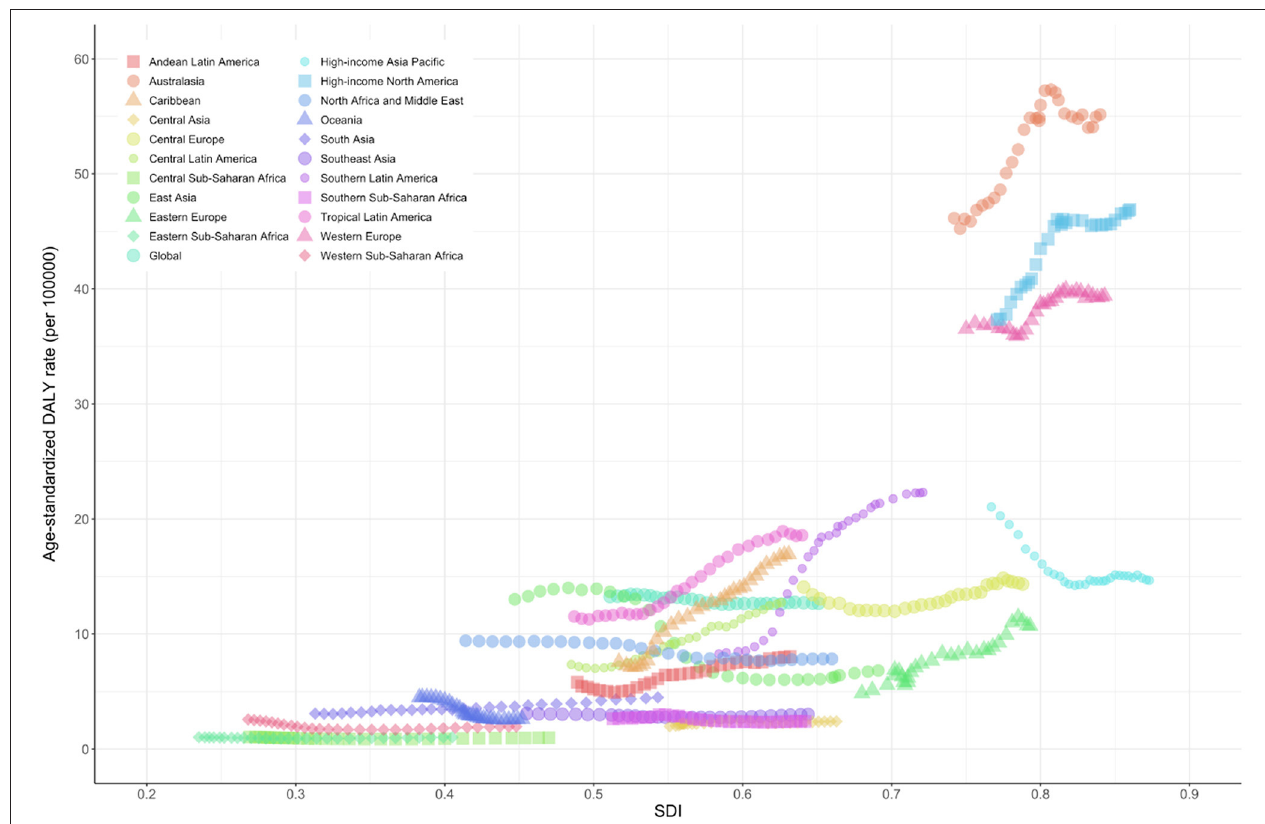
FIGURE 2 | Global disability-adjusted life-years and its age-standardized rate of motor neuron diseases by age and sex. Values are dotted at the midpoints of 5-year age categories. Shaded areas represent 95% uncertainty intervals of the age-standardized DALY rates. DALY, disability-adjusted life-years; UI, uncertainty